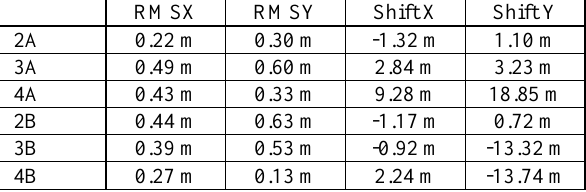
Tab. 1 : root mean square discrepancies at GCPs and shift determined by bias correction